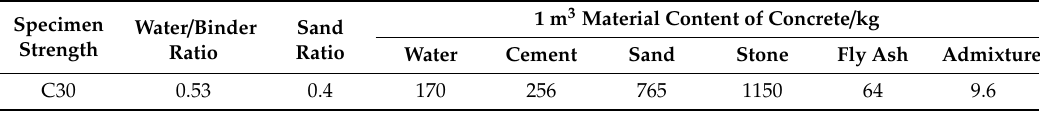
Table 1. Mix of C30 concrete.